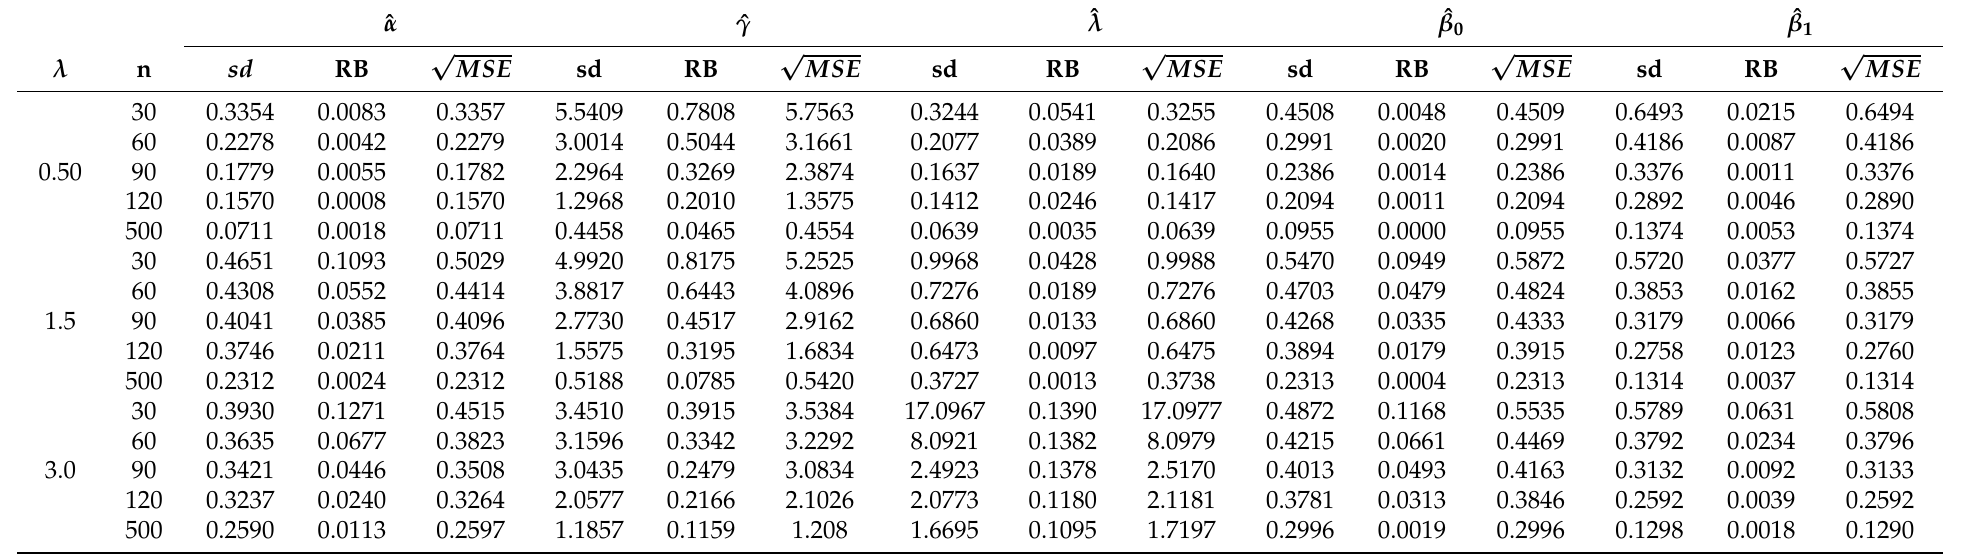
√ MSE for the EGSHN ( 1.75,2.25,0.75,2.0, λ )